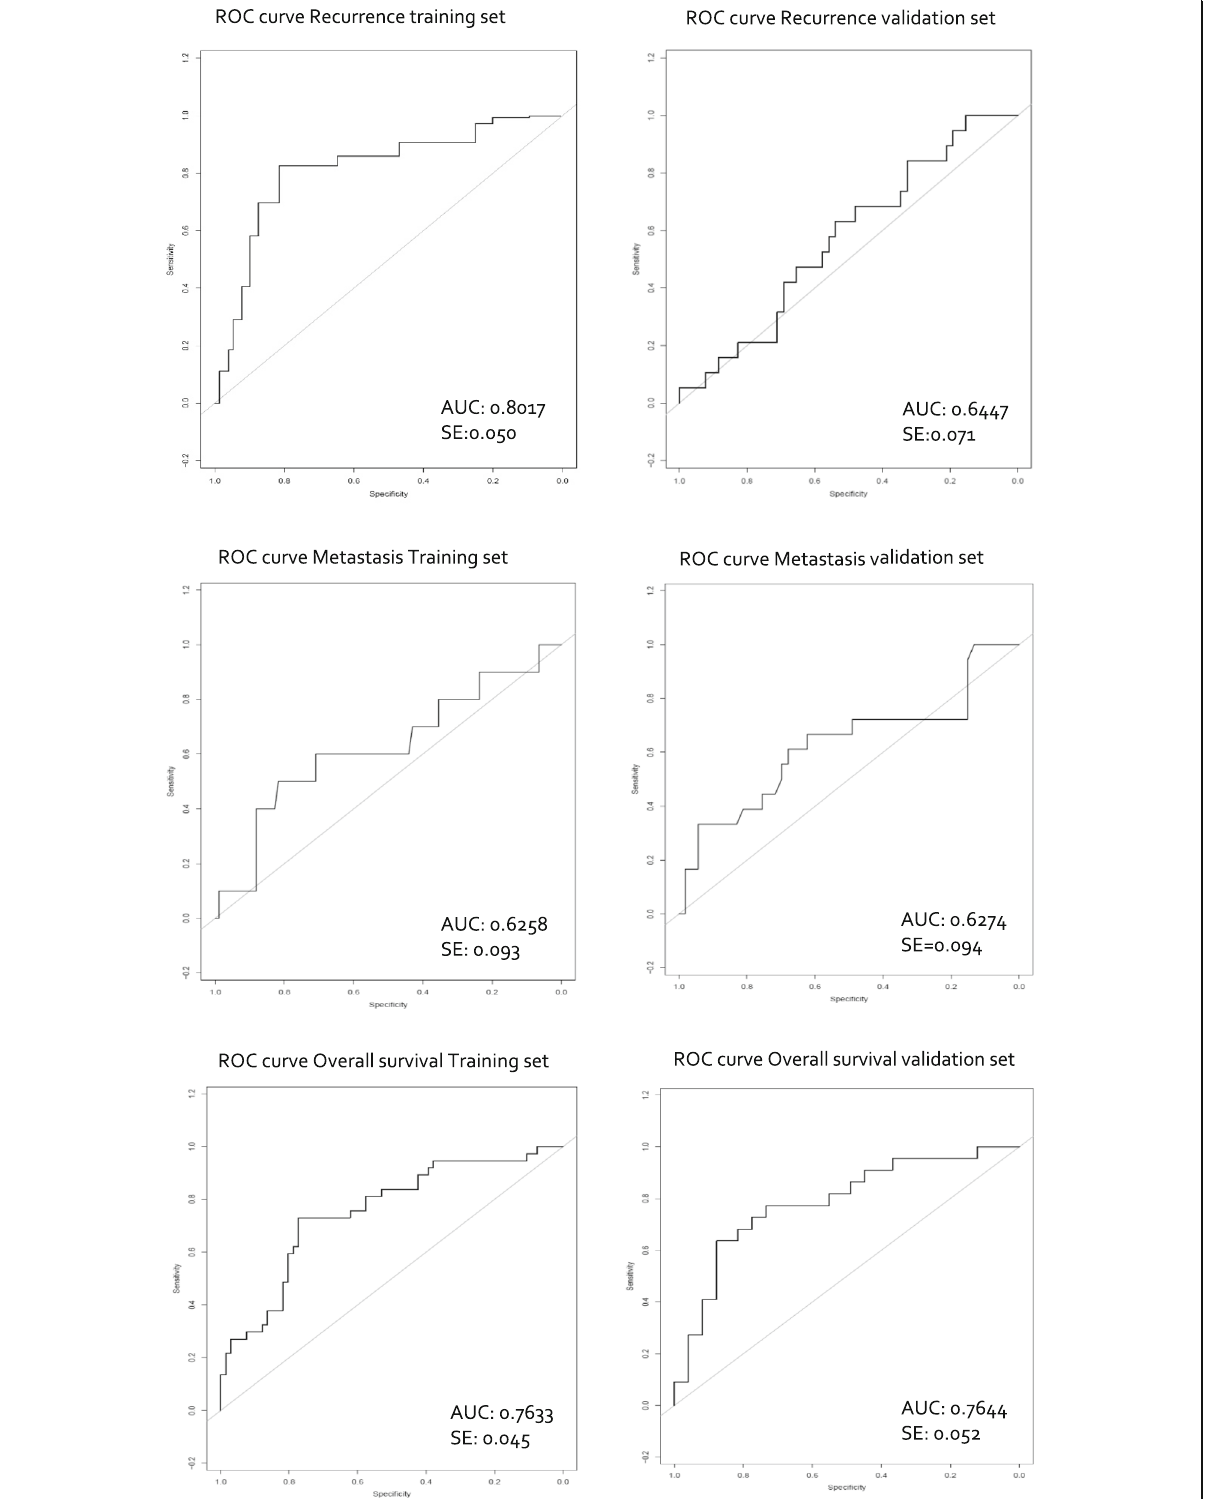
Fig. 4 ROC curves in the training and validation set per patient outcome prediction. A rea under the incident receiver operating characteristic curve (ROC) for each final model in the training set as well as in the validation set for the prediction of recurrence, metastasis, and death within 2 years of follow-up after end of